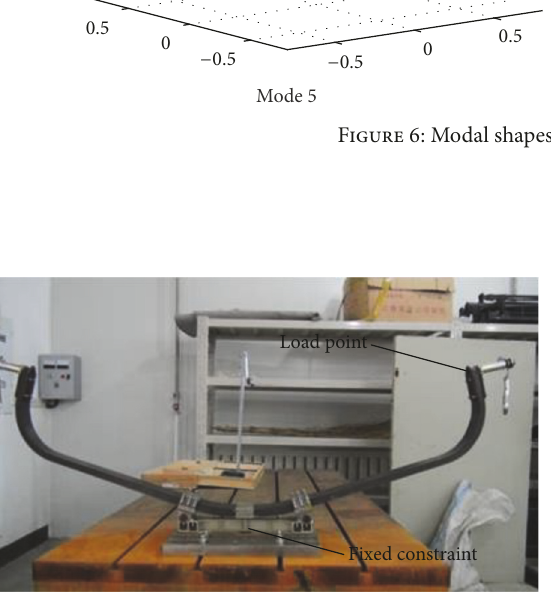
Figure 7: Setup of nonlinear static test.